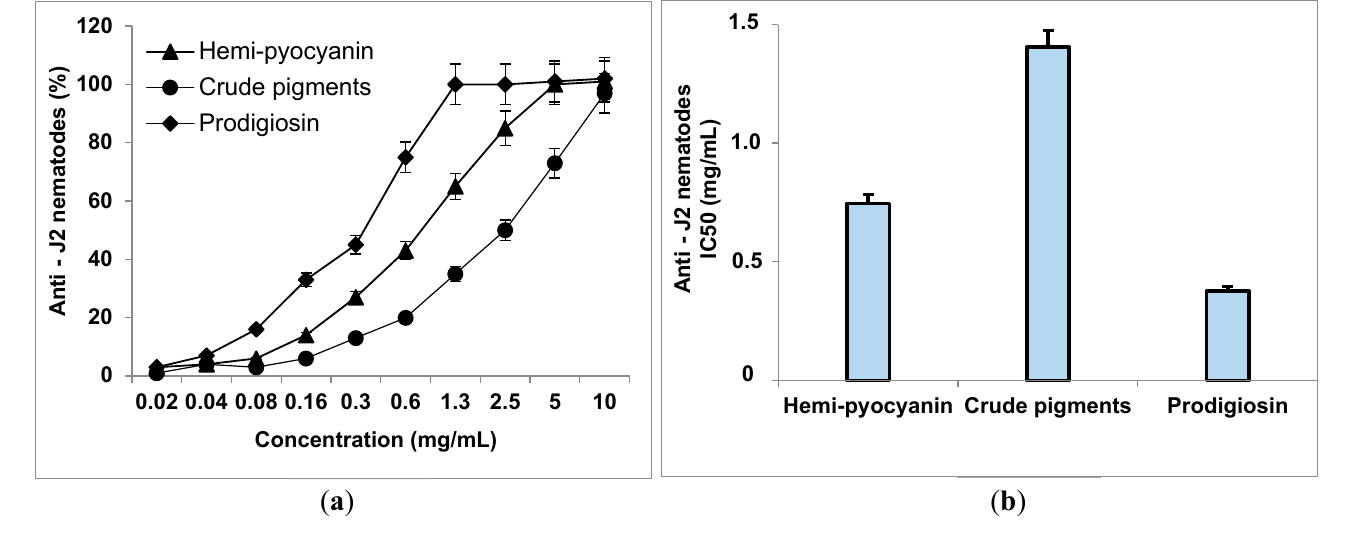
Figure 8. The anti- J2 activity (%) of purified hemi-pyocyanin, crude pigments, and prodigiosin ( a ), and their effects were expressed as IC 50 values ( b ). The experiments of the anti- J2 nematode were conducted in three repetitions. The samples were tested at various concentrations for 2 d. The mobilized and immobilized J2 nematodes were counted using stereoscopic microscope Olympus SZ5 for estimation of the inhibitory activity.